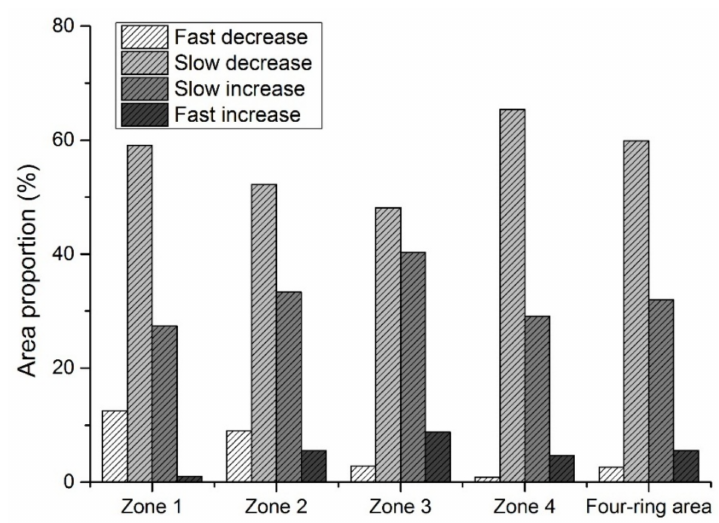
Figure 5. Extent of direct runoff trend in different